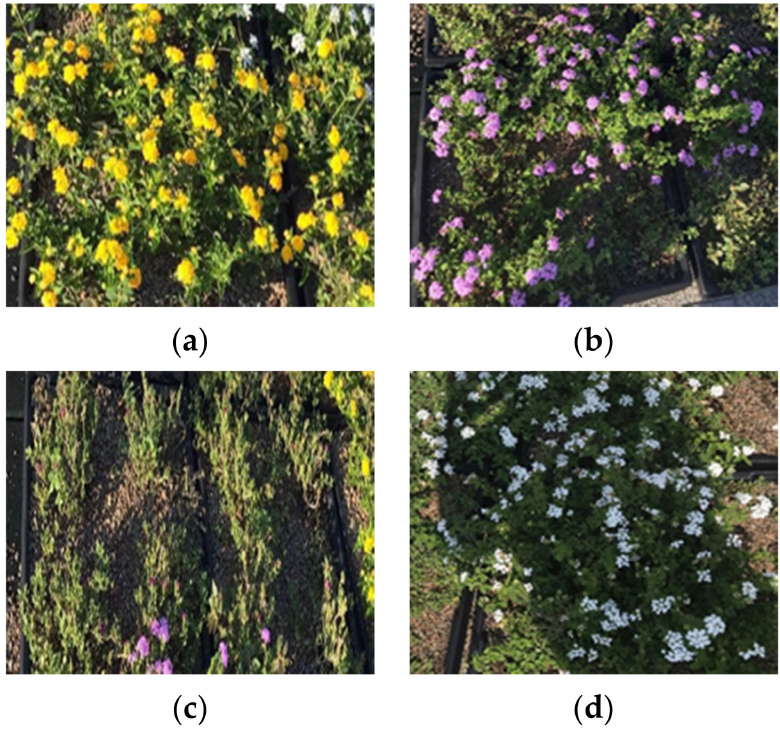
Figure 2. Four species considered in this study: ( a ) New Gold Lantana; ( b ) Purple Trailing Lantana; ( c ) Hardy Ice Plant; ( d ) White Trailing Lantana.